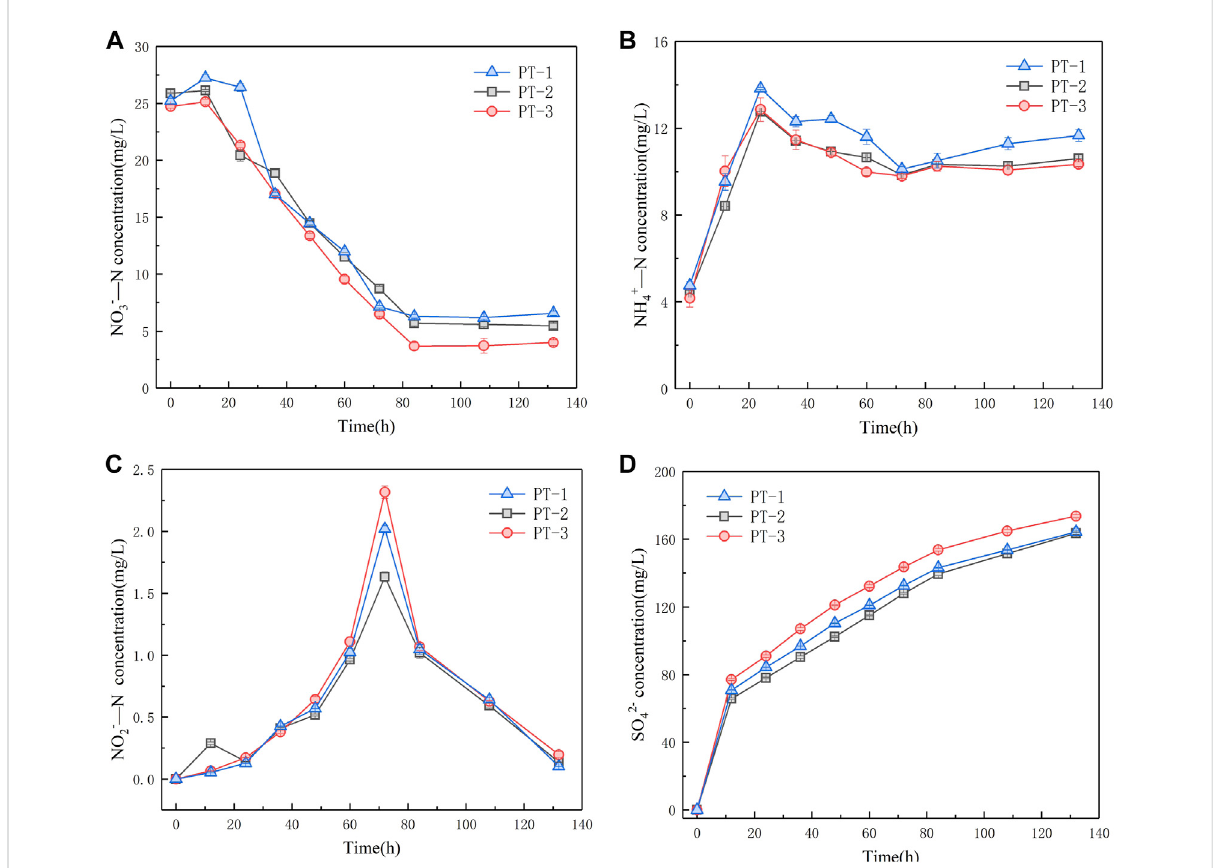
FIGURE 5 Variation of NO 3 − -N concentration (A) , NH 4 + -N concentration (B) , NO 2 − -Nconcentration (C) , and SO 4 2 − concentration (D) in three granular denitri fi cation systems of pyrite